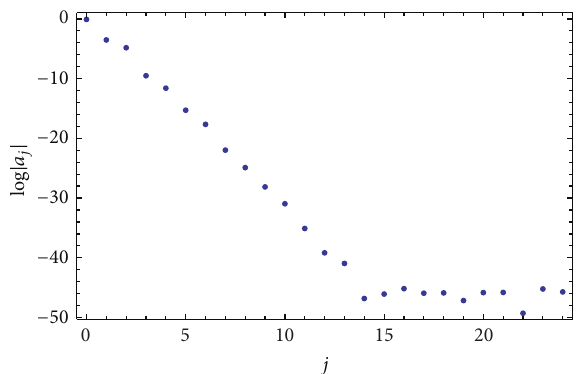
Figure 3: Logarithmic graph of absolute coefficients |𝑎 𝑗 | of shifted Jacobi polynomials for 𝑛 = 3/2 , 𝜆 = 0.5 , and 𝛼 = 𝛽 = 1 at 𝑁 = 24 .